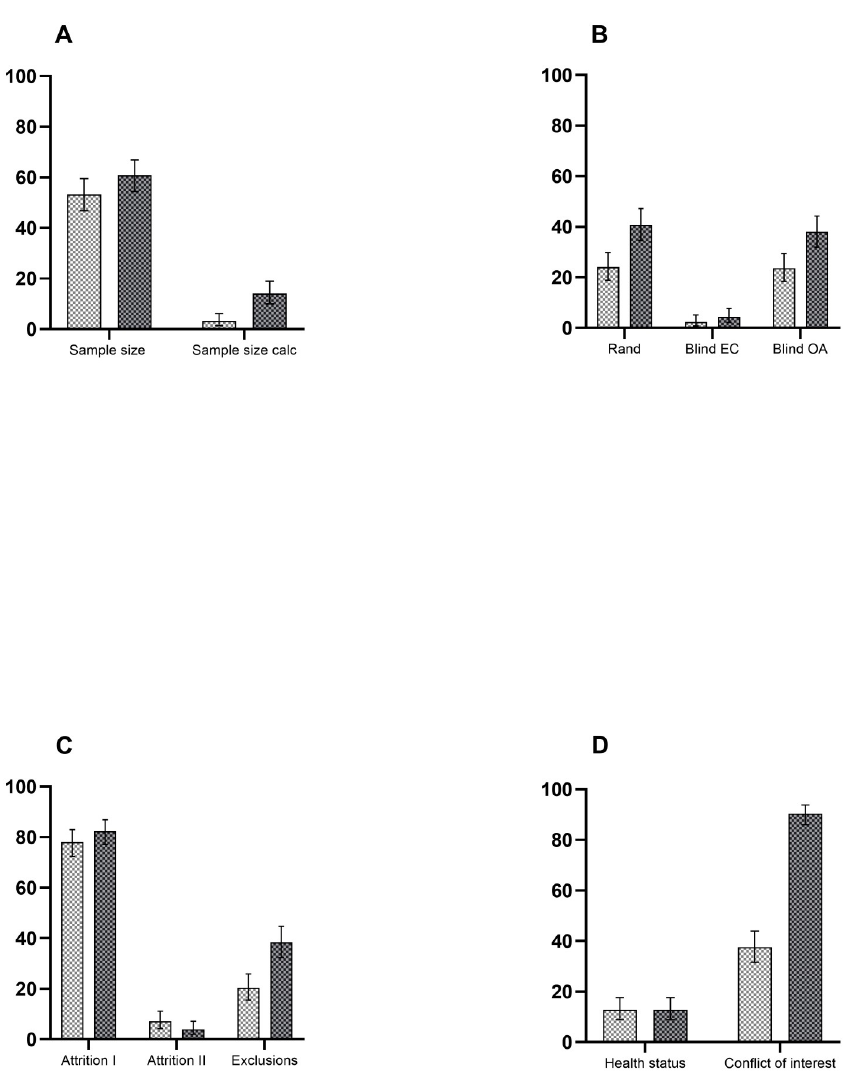
Fig 2. Prevalence of reporting quality in Danish preclinical research in 2009 compared to 2018. Left Y-axis : prevalence of reporting in %. X-axis : ( A ) sample size and sample size calculation, ( B ) randomization (Rand), blinded experiment conduct (Blind EC), and blinded outcome assessment (Blind OA), ( C ) attrition I (reporting numbers of samples/animals in the result section), attrition II (reporting consistency in numbers of samples/animals between methods and result section), and exclusions (reporting numbers of samples/animals excluded), ( D ) health status and conflict of interest. The error bars represent 95% confidence intervals. Light grey bars: 2009. Dark grey bars: